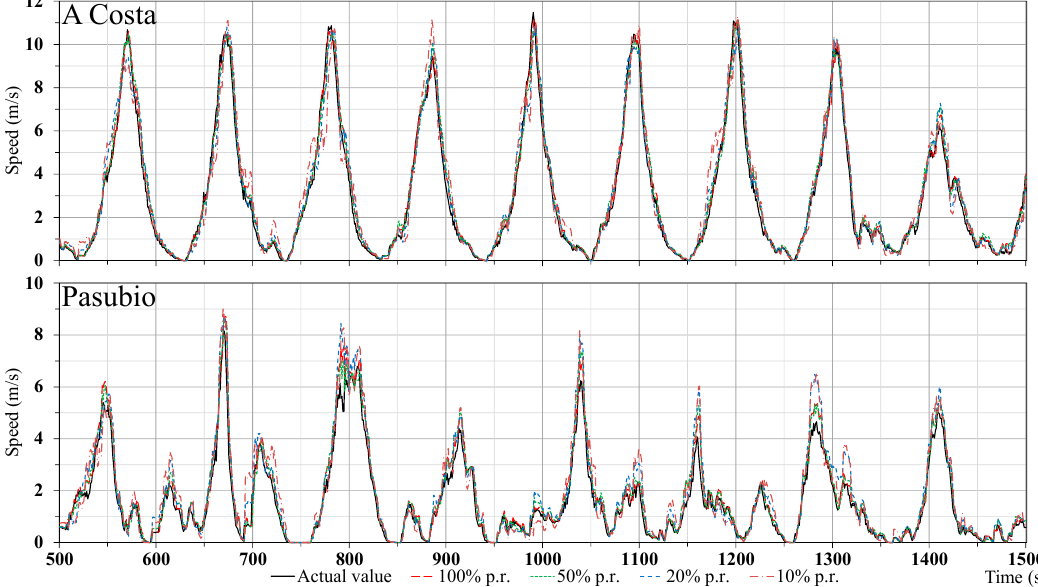
Figure 4. Average speed over time for different penetration rates; regardless of the considered scenario and penetration rate, the value determined by TraSLowPeR is very similar with the actual value.